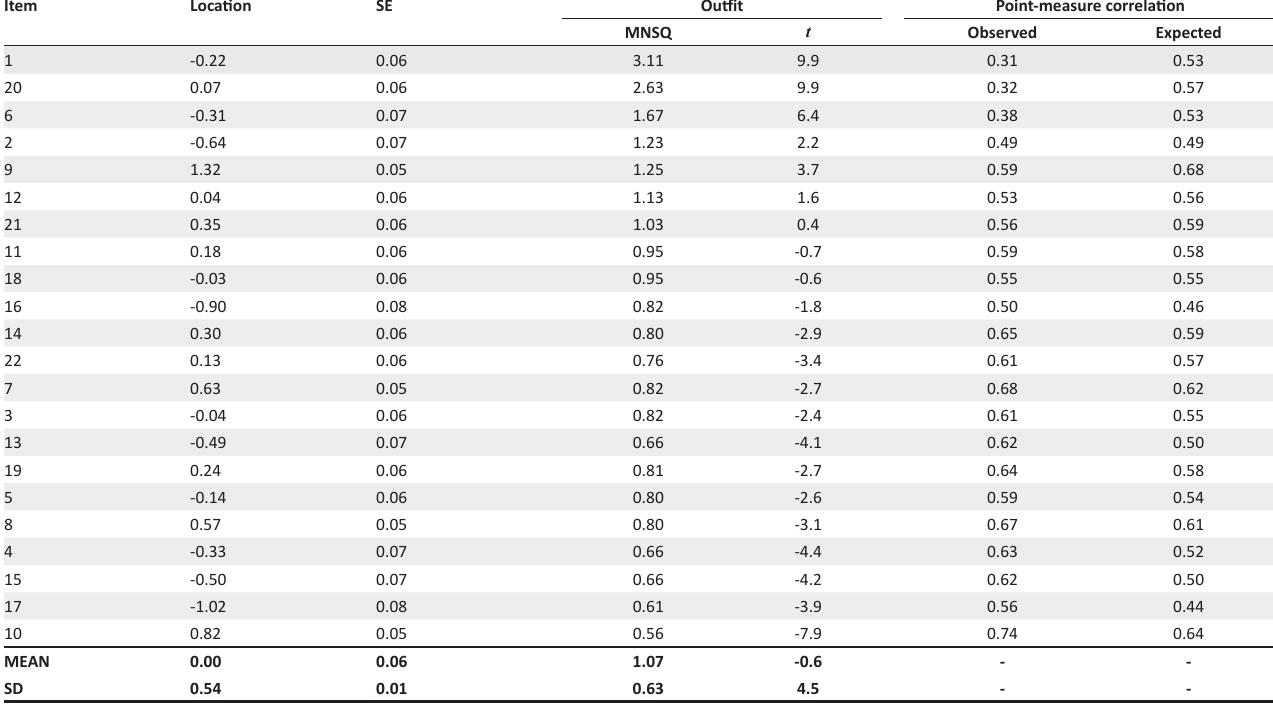
TABLE 1: Rasch item calibrations and fit statistics for 22 items (sorted according to fit). Item Location SE